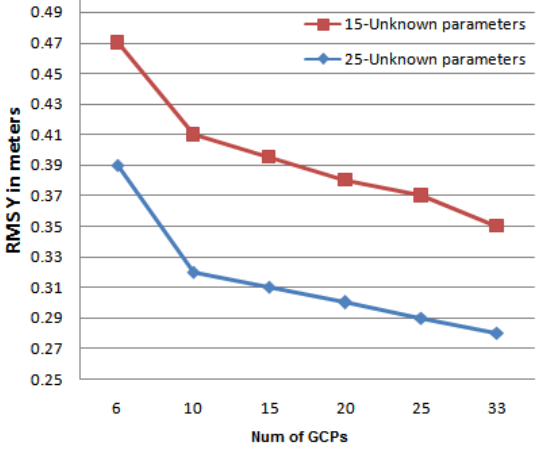
Table 1. Residuals of bundle adjustment with 25 unknown